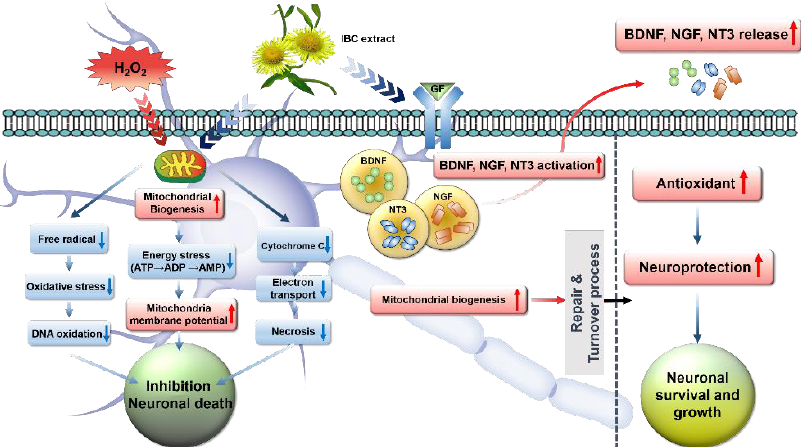
Figure 10. Schematic illustration showing the cascade of events involved in mitochondrial dysfunction after H 2 O 2 treatment and the therapeutic regulation of IBC extract with varying concentrations through ROS scavenging, suppressing oxidative stress and cell death, enhancing mitochondrial function and neuronal cell growth, and consequently axonal regeneration.